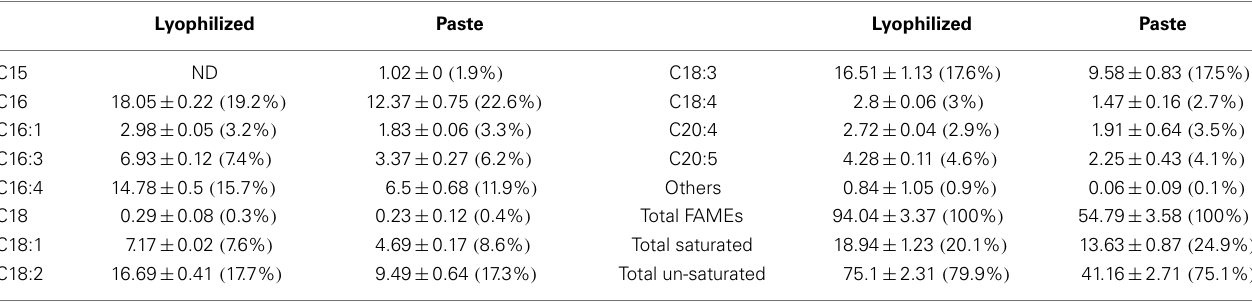
Table 1 | Quantitative fatty acid profiles of extracted lipids from wet algal paste or lyophilized biomass of Tetraselmis sp. M8 using the Bligh & Dyer extraction method followed by FAME analysis using GC-MS . Lyophilized Paste Lyophilized